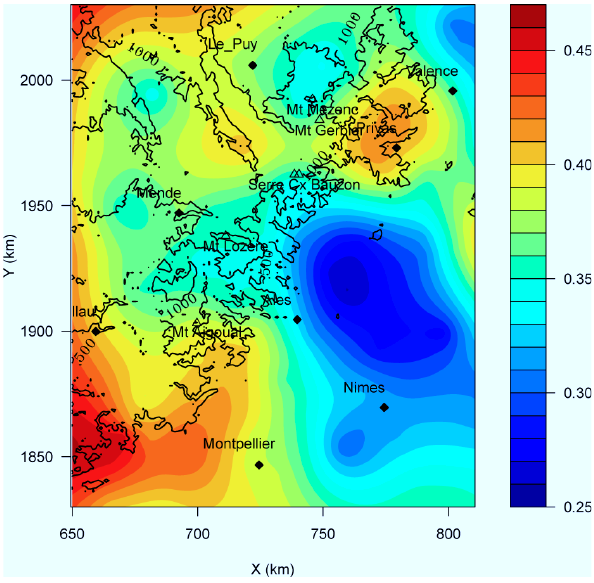
Fig. 9. Kriging error for RS3 evaluated as the kriging standard- deviation normalized by the 100-yr return